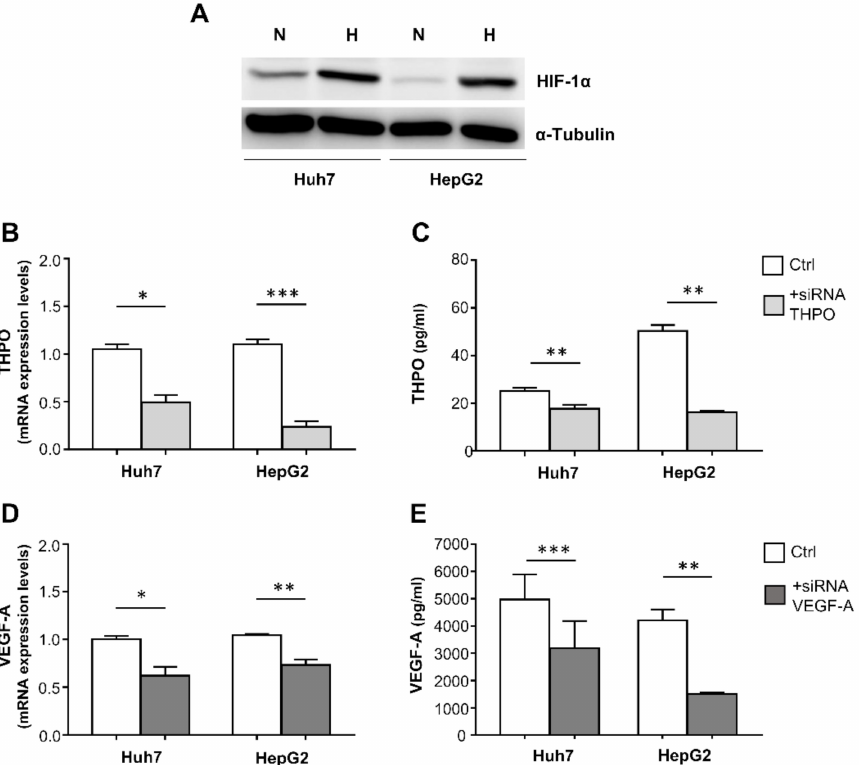
Figure 8. Hypoxia (H) induces an increase in HIF-1 α protein, detected by Western blotting, compared with normoxia (N) in Huh7 and HepG2 cells ( A ). THPO and VEGF-A silencing in hypoxic Huh7 and HepG2 liver cancer cells: mRNA expression and protein levels were analyzed 72 h after transfection with THPO ( B , C ) and VEGF-A ( D , E ) siRNA. Results are expressed as mean ± SEM of 4 separate experiments; p values were obtained by paired t test (* p < 0.05, ** p < 0.01, *** p <